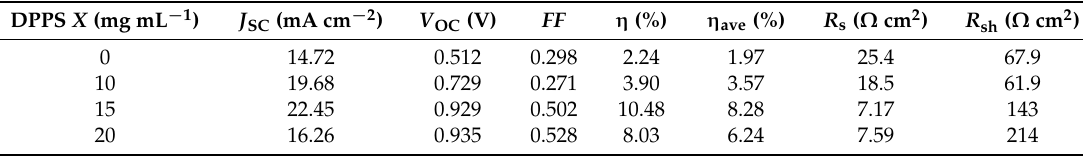
Figure 6. J – V characteristics of the MAPbI 3 /(DPPS) ( X mg mL − 1 ) perovskite solar cells. The standard system is the device after 49 days, and the system added with DPPS is the device after 48 days. Table 3. Measured photovoltaic parameters of the MAPbI 3 /(DPPS) ( X mg mL − 1 ) perovskite solar cells. The standard device is after 49 days and the device added with DPPS is after 48 days.